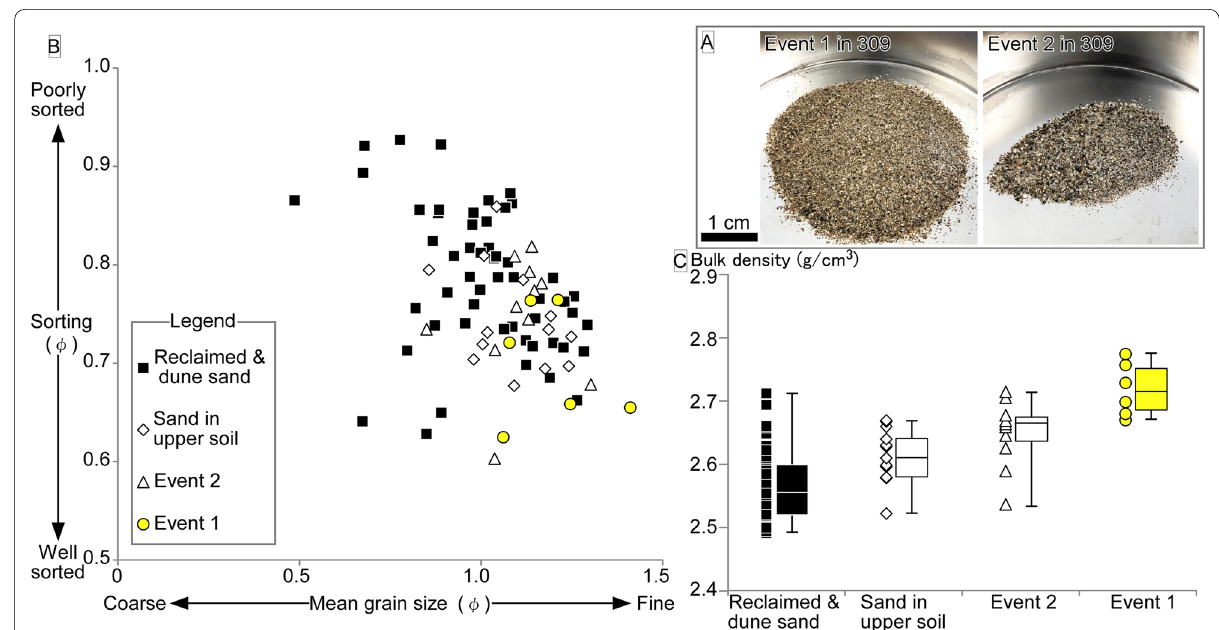
Fig. 6 A Photographs of sand from Events 1 and 2. B Grain sorting plotted against mean grain size. C Bulk density of sediment